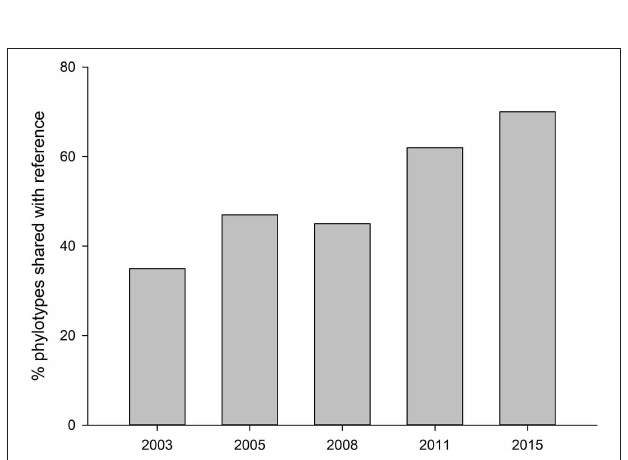
FIGURE 2 | Proportion of fungal phylotypes shared with reference site across the restoration chronosequence.